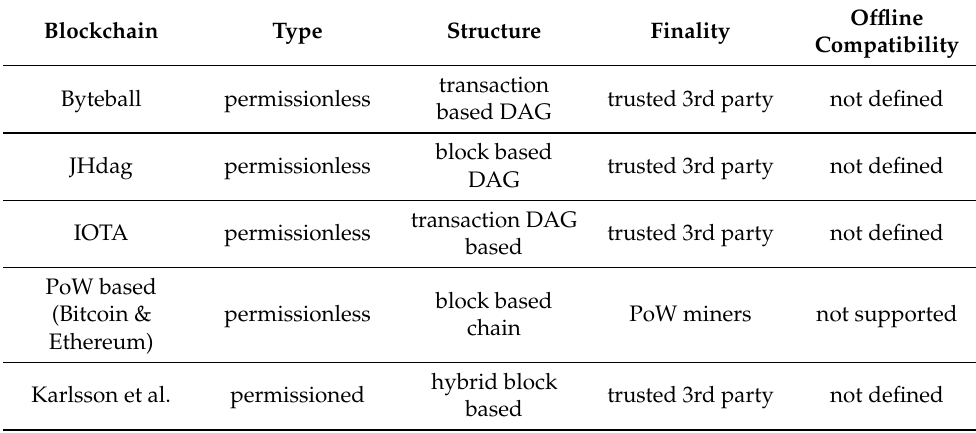
Table 1. Table to compare attributes of past